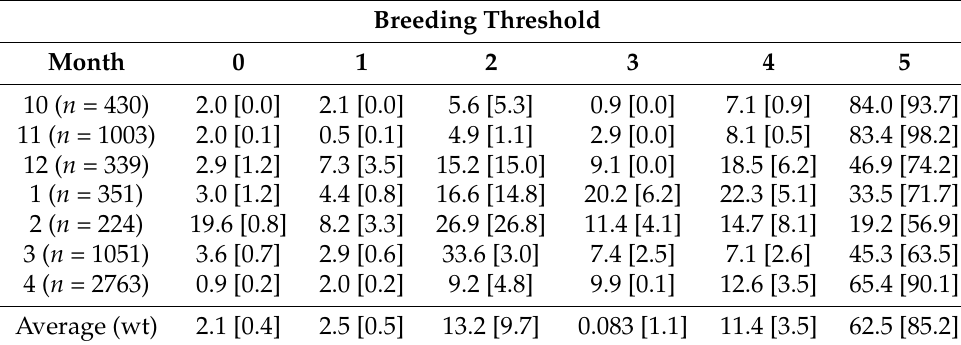
Table 1. Percentages (%) of DL observations under each threshold analyzed by month at the level of one pixel (3 × 3 km). Brackets show the corresponding percentages for a buffer of 3 × 3 pixels (9 × 9 km). See the text or Figure 2 for threshold